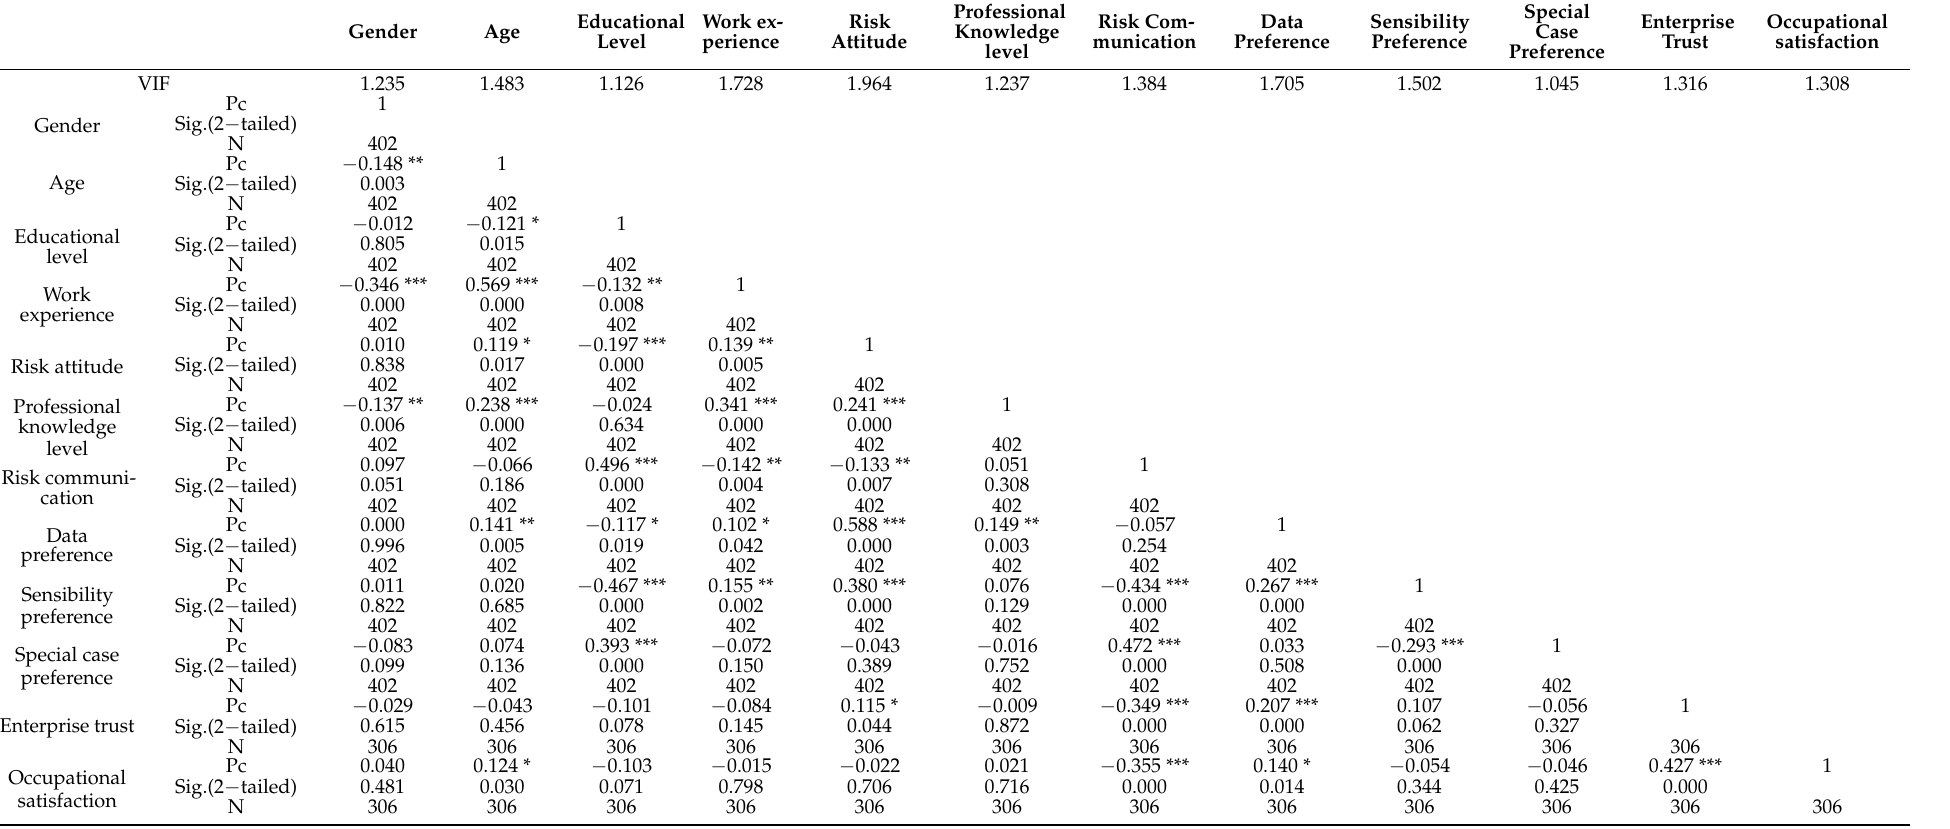
Table 7. Correlations between independent variables and the VIF value of each